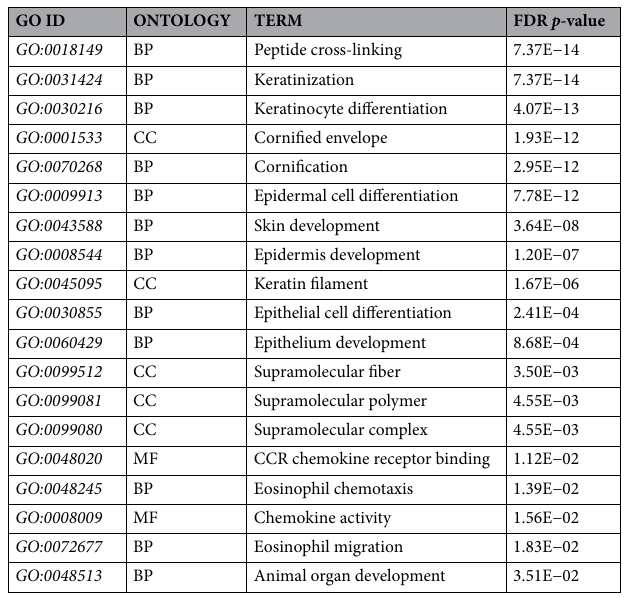
Table 1. Significant (FDR p -value < 0.05) Gene Ontology pathways enriched in differentially methylated sites from the full term placenta analysis.